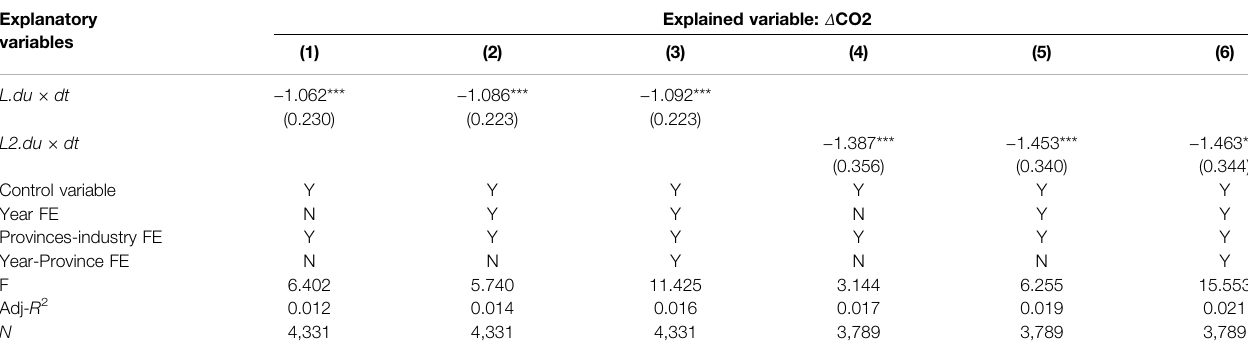
TABLE 4 | Analysis of lag effect. Explanatory